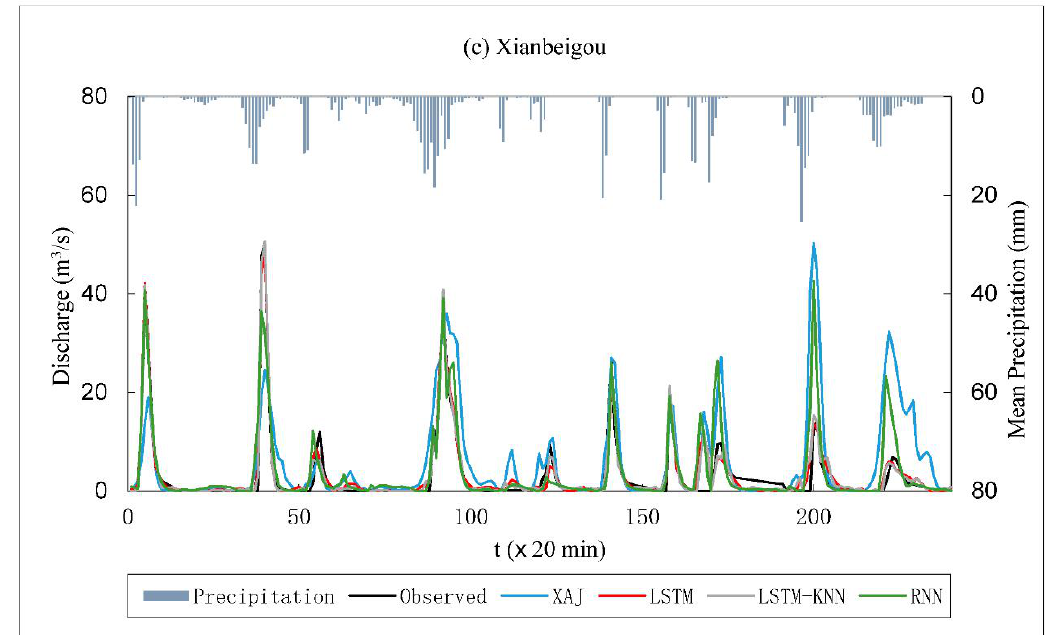
Figure 6. The observed and the estimated hydrographs using four models (XAJ, LSTM, LSTM-KNN, RNN) in Tunxi, Chenhe and Xianbeigou Catchment.